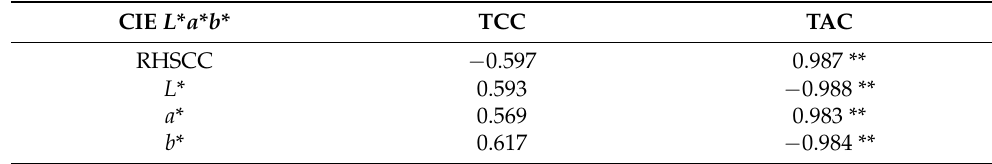
Table 3. Pearson correlation between color parameters and pigment